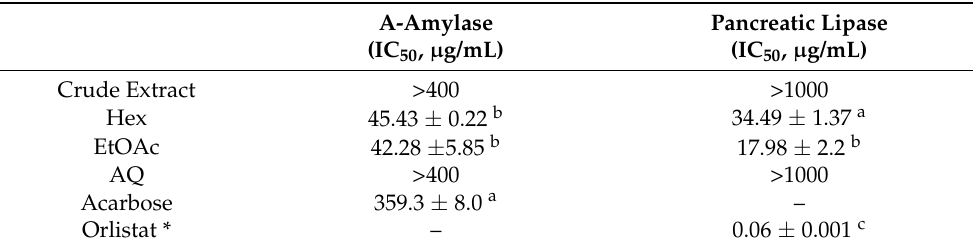
Table 4. Inhibitory ability of S. vulgare crude hydroacetonic extract and purified fractions towards α -amylase and pancreatic lipase